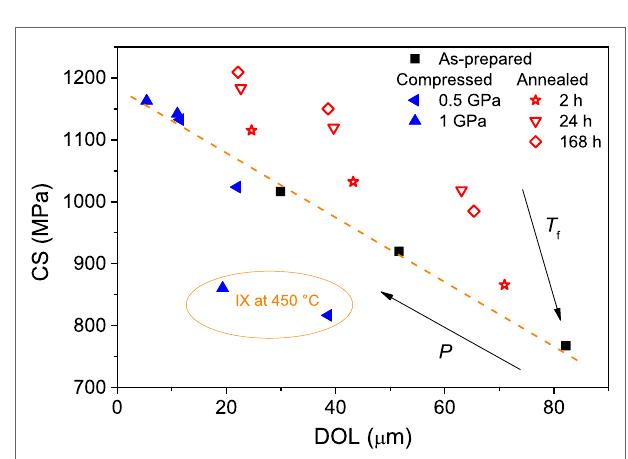
FigUre 6 | activation energy ( E a ) of the na + –K + interdiffusivity as a function of density ( ρ ) . The range of density values has been obtained by annealing and isostatic compression. The dashed line is a guide for the eye.